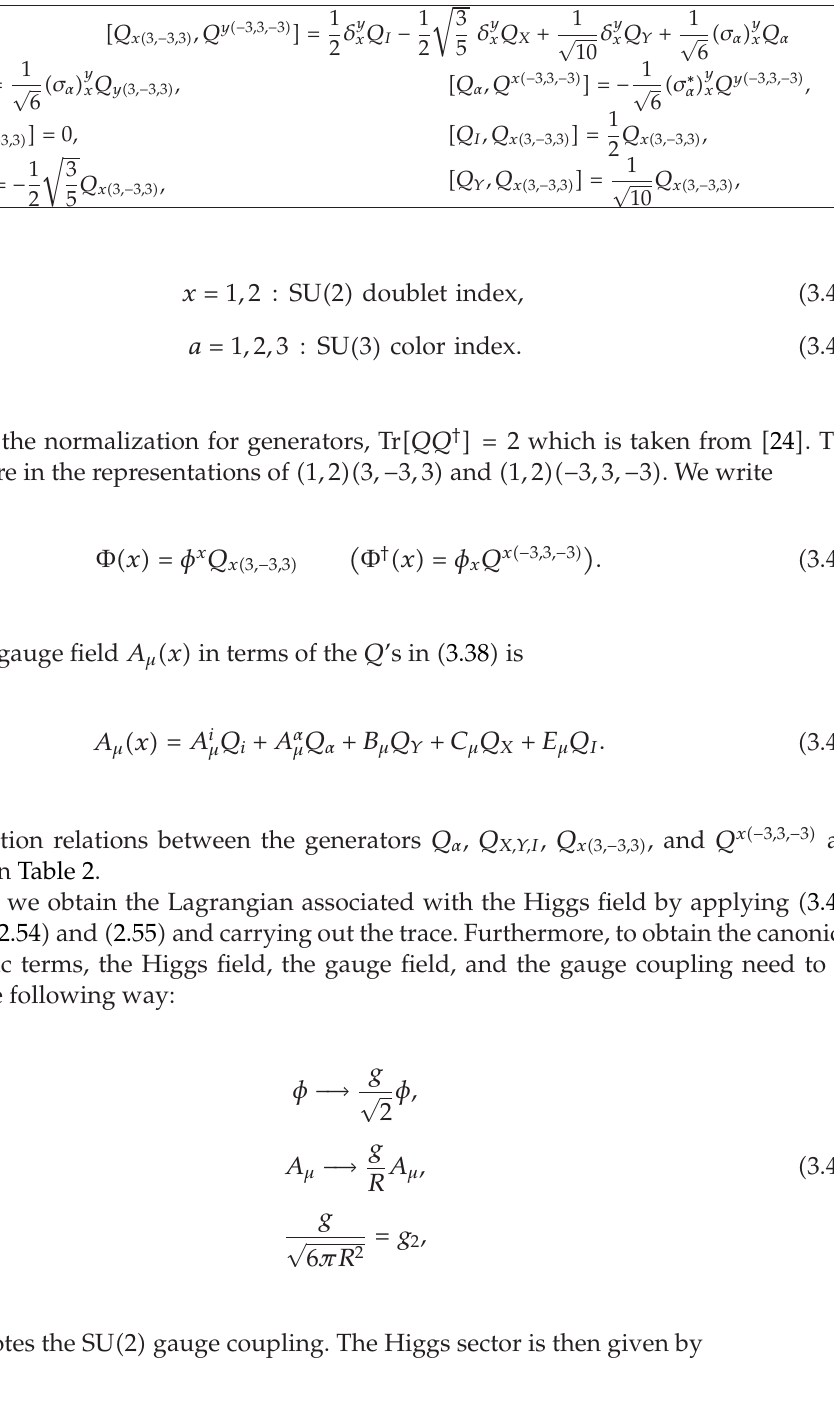
Table 2: Commutation relations of Q